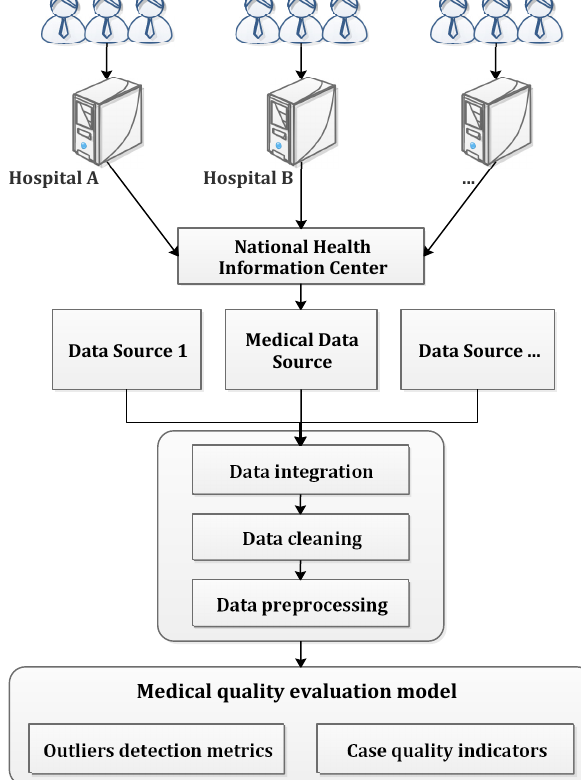
Figure 6. Data preparation